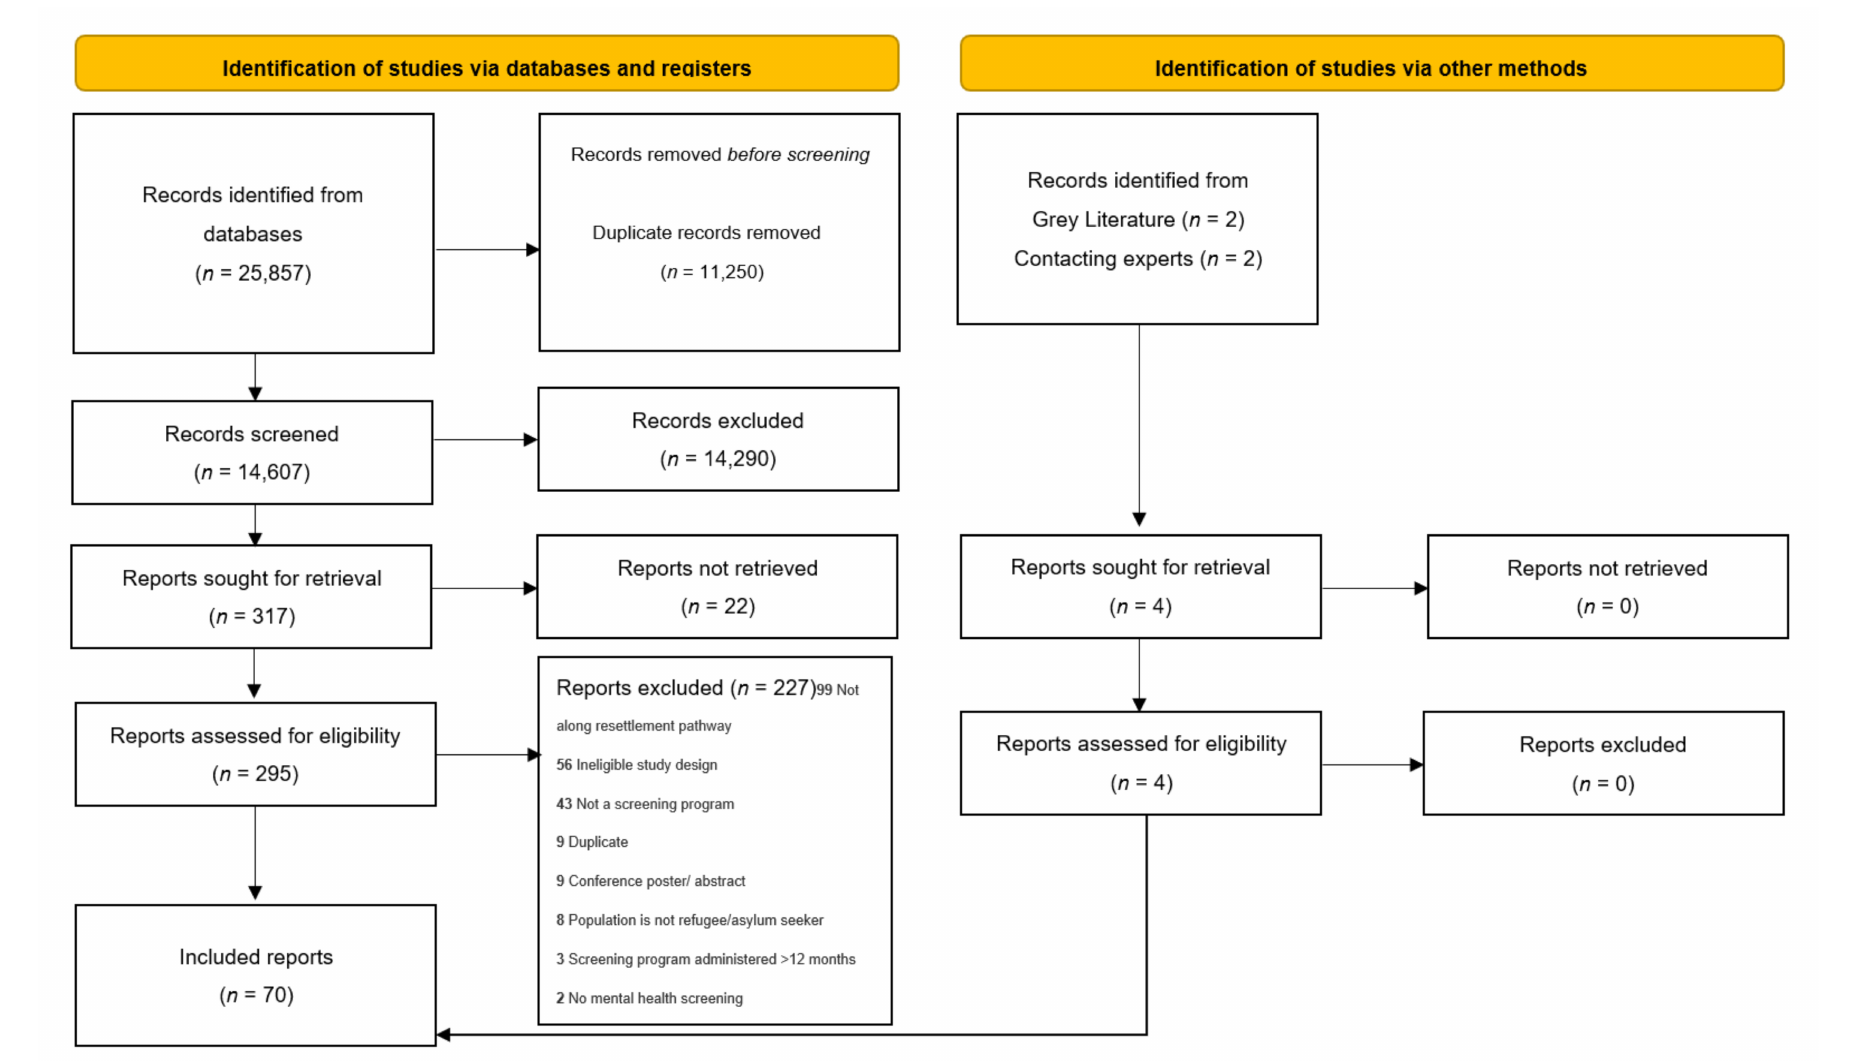
Figure 2. PRISMA Flow